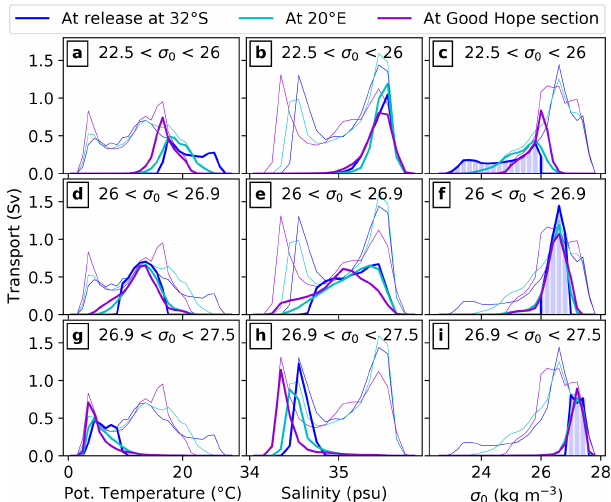
Figure 6. Thermohaline property modification of Agulhas leakage waters for experiment P: transport of (a–c) upper waters (22 . 5 < σ 0 < 26), (d–f) central waters (26 < σ 0 < 26 . 9) and (g–i) AAIW (26 . 9 < σ 0 < 27 . 5) per potential temperature ( a, d, g , 1 ◦ C bins), salinity ( b, e, h , 0.1 psu bins) and σ 0 ( c, f, i , 0.2kgm − 3 bins) class. To assign waters to these water masses, σ 0 in the Agulhas Current at 32 ◦ S is used, highlighted by the blue shading. The properties at the release at 32 ◦ S are shown as blue, at 20 ◦ E as cyan and at the first crossing of the Good Hope section as purple lines. The thin lines show the transport of all water masses together including the deep waters ( σ 0 > 27 . 5).